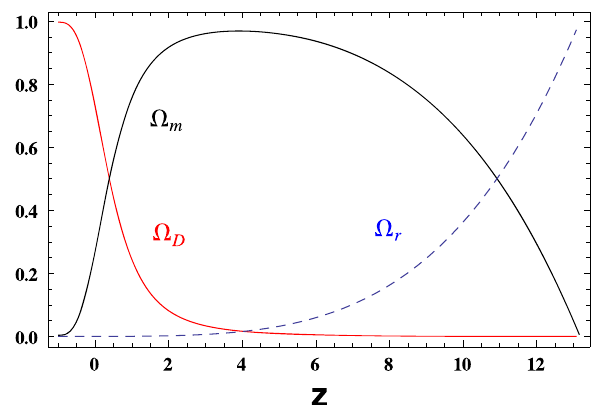
= Fig. 10 The evolution of ω D versus redshift parameter z for (cid:5) 0 D = 2 . 47 × 10 − 5 , b 2 = 0 . 03, b 2 = 0 . 01, δ = 1 . 4 (black Fig. 8 Upper panel: The evolution of the density parameters (cid:5) D (red 0 . 73, (cid:5) r 1 2 0 line), (cid:5) m (black line) and (cid:5) r (dashed line) as a function of z is shown curves), δ = 1 . 55 (gray curves), δ = 2 . 0 (red curves) and δ = 2 . 2 (blue = 0 . 73, (cid:5) = 2 . 47 × 10 − 5 , for the present model considering (cid:5) 0 curves). A dashed (solid) curve represents the corresponding evolution r 0 D = 0 . 15, b 2 = 0 . 06 and δ = 2 . 1, as indicated in each panel b 2 of (cid:5) D when radiation fluid is present 1 2